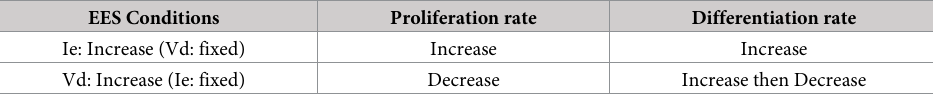
Table 1. Summary of the effect of EES on the proliferation and differentiation of MC3T3-E1